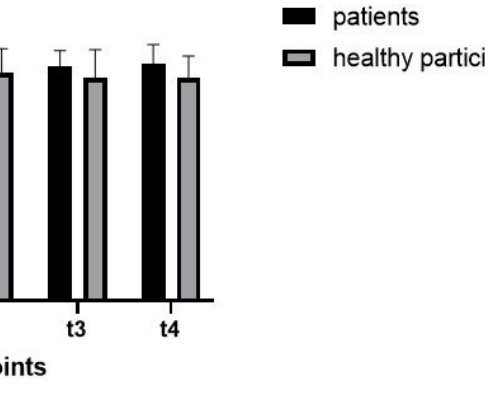
Figure 6. Mean values of measured skin temperature at different timepoints.